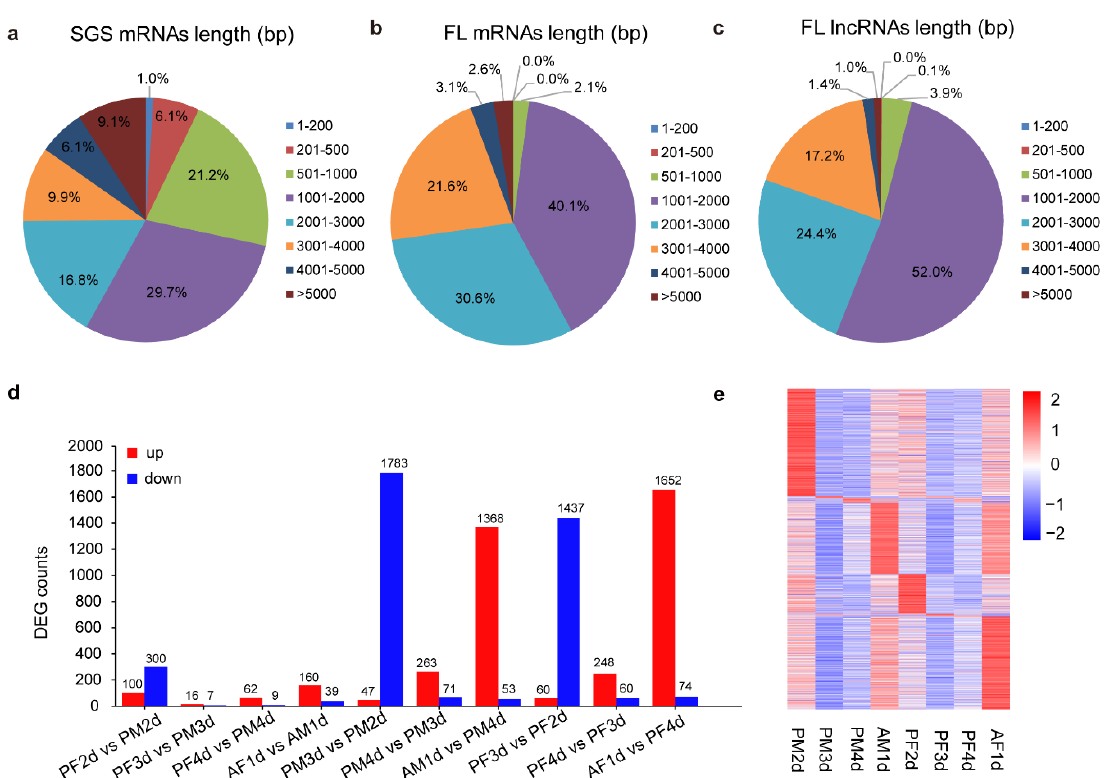
Figure 2. Long non-coding RNA (lncRNA) identification and differential expression patterns of pharate adult and adult development of both sexes in C. vestalis . ( a – c ) Length distributions of mRNAs identified in SGS data ( a ) and Iso-Seq data ( b ) as well as lncRNAs identified in Iso-Seq data ( c ). FL: full length. ( d ) Analysis of differential expression lncRNAs between pharate adult and adult development of females and males C. vestalis. Red bars represent up-regulated and blue bars represent down-regulated lncRNAs. PM2d, PM3d, PM4d, AM1d, PF2d, PF3d, PF4d, and AF1d represent C. vestalis two-day-old male pupae, three-day-old male pupae, four-day-old male pupae, one-day-old male adults, two-day-old female pupae, three-day-old female pupae, four-day-old female pupae, and one-day-old female adults, respectively. ( e ) Stage-specific expression patterns of lncRNAs in C. vestalis. Red and blue colors in the heat map indicate high and low expression levels, respectively.